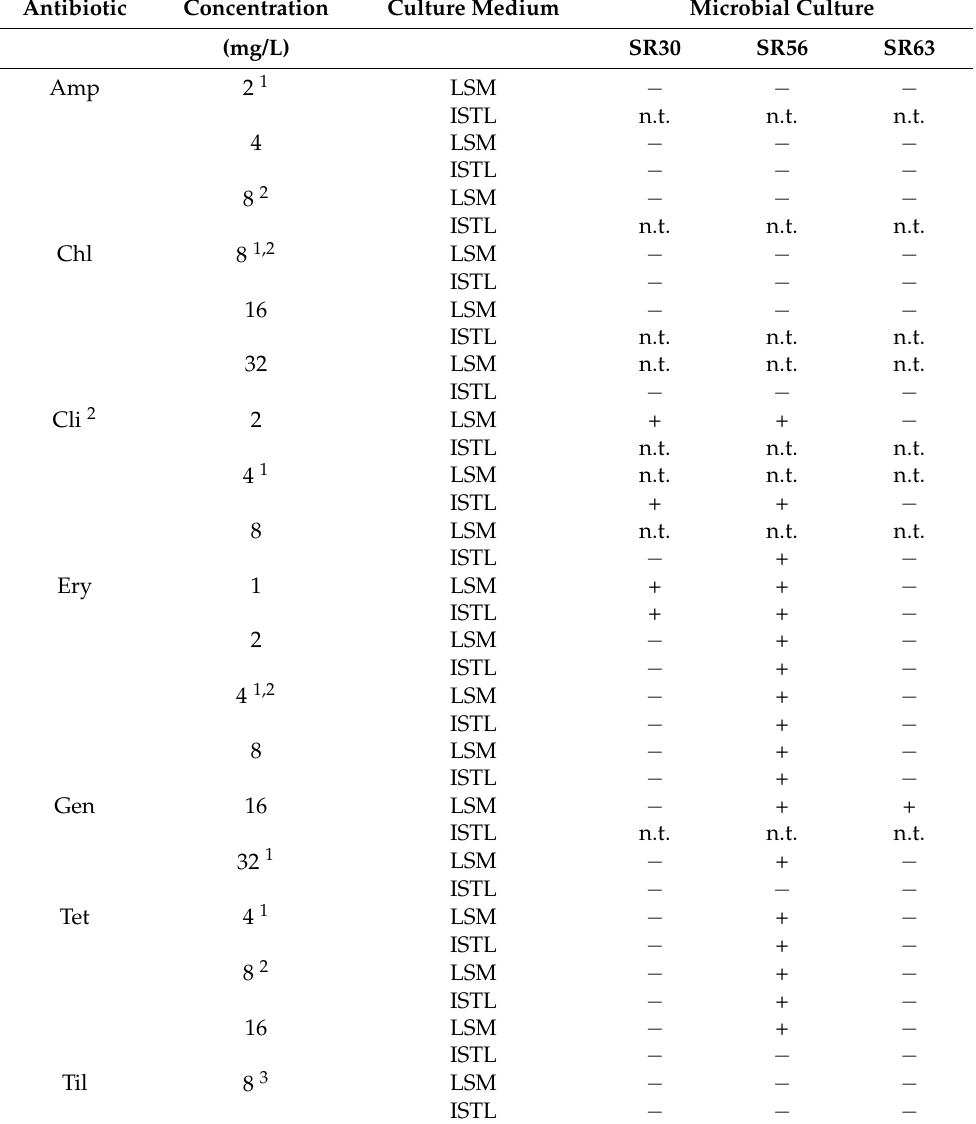
Table 1. Evaluation of antibiotic resistance of the SR30, SR56, and SR63 cultures in toto , in media supplemented with different antibiotic